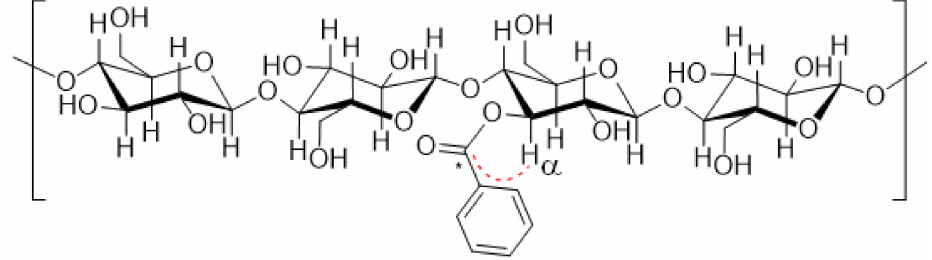
Figure 1. Chemical modification and corresponding NMR proof of the covalent character of such modifications graphically exemplified within a cellulosic part of wood. The 1 H, 13 C-HMBC con- firmed 3 J C,H spin–spin coupling cross signal (see text) is marked with a red dotted line. Additional cross peaks attributed to corresponding modification of lignin parts in addition to cellulose and hemicellulose regions are given as original NMR cross peaks in Figure